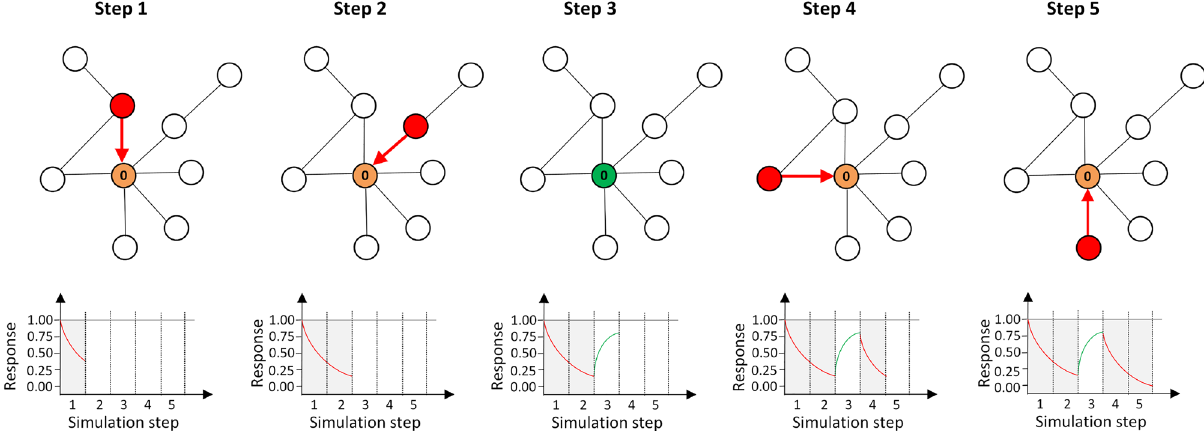
Figure 4. Exemplary process showing the impact of repeated contacts on the responsiveness of nodes. Steps 1 and 2 with repeated contacts result in a two-stage drop of responsiveness, which can result in a decrease in activation probability. In Step 3, no contact attempts are performed, and node zero partially recovers. After that, two consequent stages with communication attempts result in another responsiveness